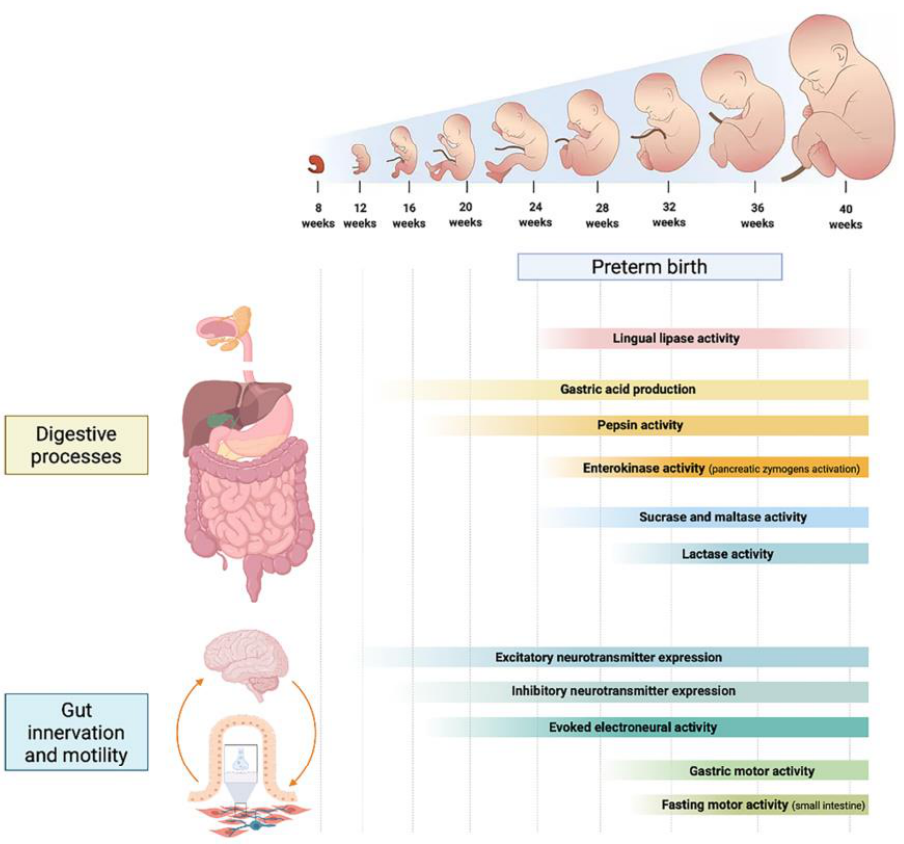
Figure 1. Developmental phases of the main digestive processes, gastrointestinal innervation and motility patterns throughout different gestational weeks.